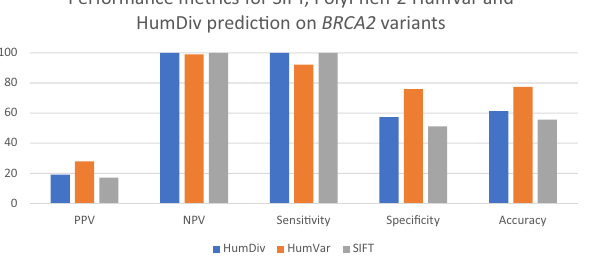
Figure 2. Performance metrics for SIFT, PolyPhen-2 HumVar and HumDiv predictions on BRCA2 variants with known clinical significance.